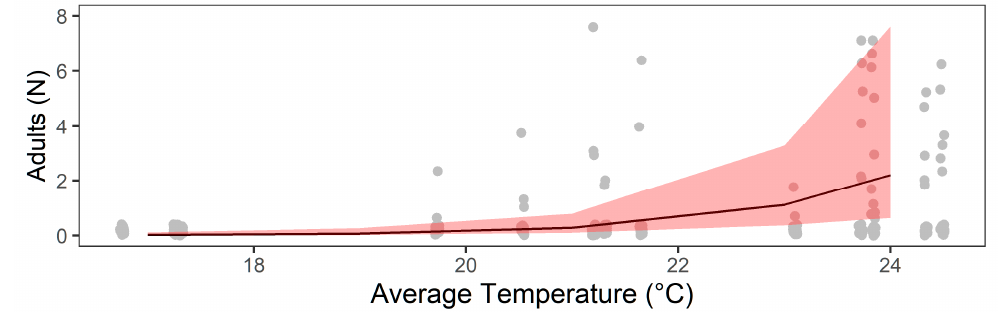
Figure 7. Effect of the average temperature (ß = 1.82 ± 0.42; z = 4.36; p < 0.001) on the number of hatched adults Aedes from eggs collected in ovitraps between September 2017 and September 2018, Morretes, Paran á , Brazil. The shaded areas are the 95% confidence intervals, and the gray points are the raw